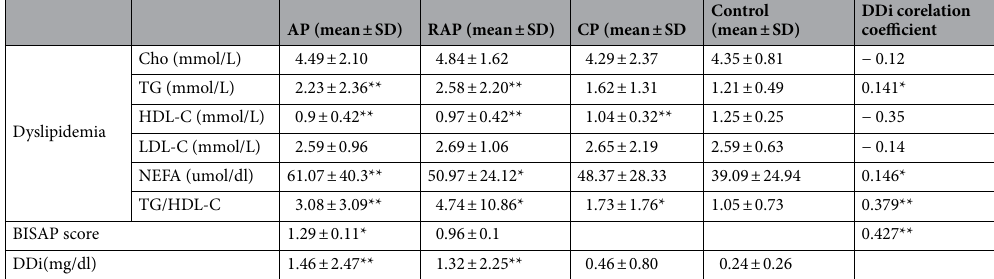
Table 2. Dyslipidemia and severity in types of pancreatitis. AP acute pancreatitis, RAP recurrent acute pancreatitis, CP chronic pancreatitis, TG triglyceride, Cho cholesterol, LDL-C low-density lipoprotein cholesterol, HDL-C high-density lipoprotein cholesterol, NEFA non-esterified fatty acids, BISAP bedside index of severity in acute pancreatitis. *p < 0.05; **p < 0.01.